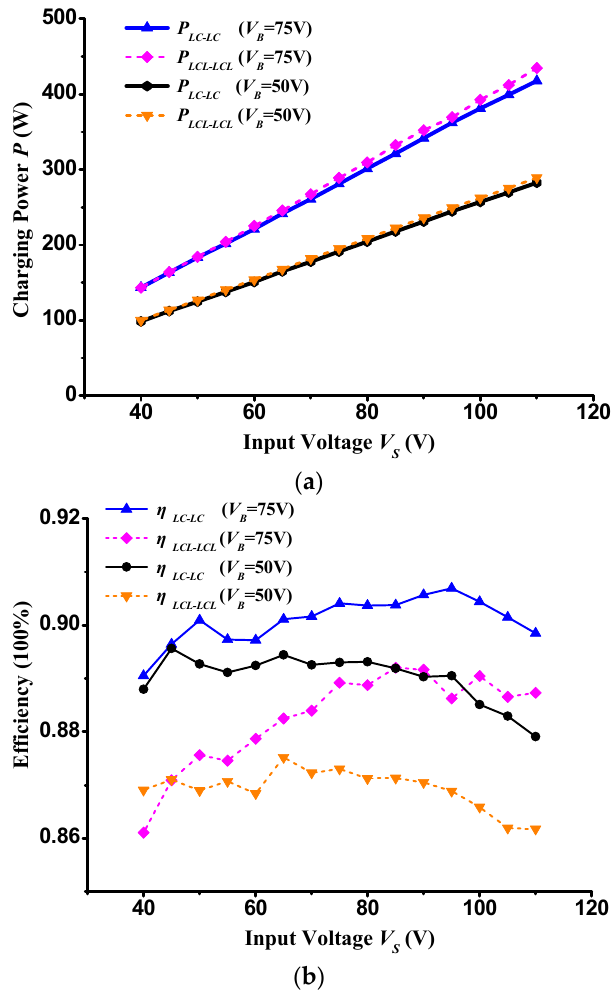
Figure 4. Experimental transfer power ( a ) and efficiencies ( b ) of the LC ‐ LC series and LCL ‐ LCL topologies.